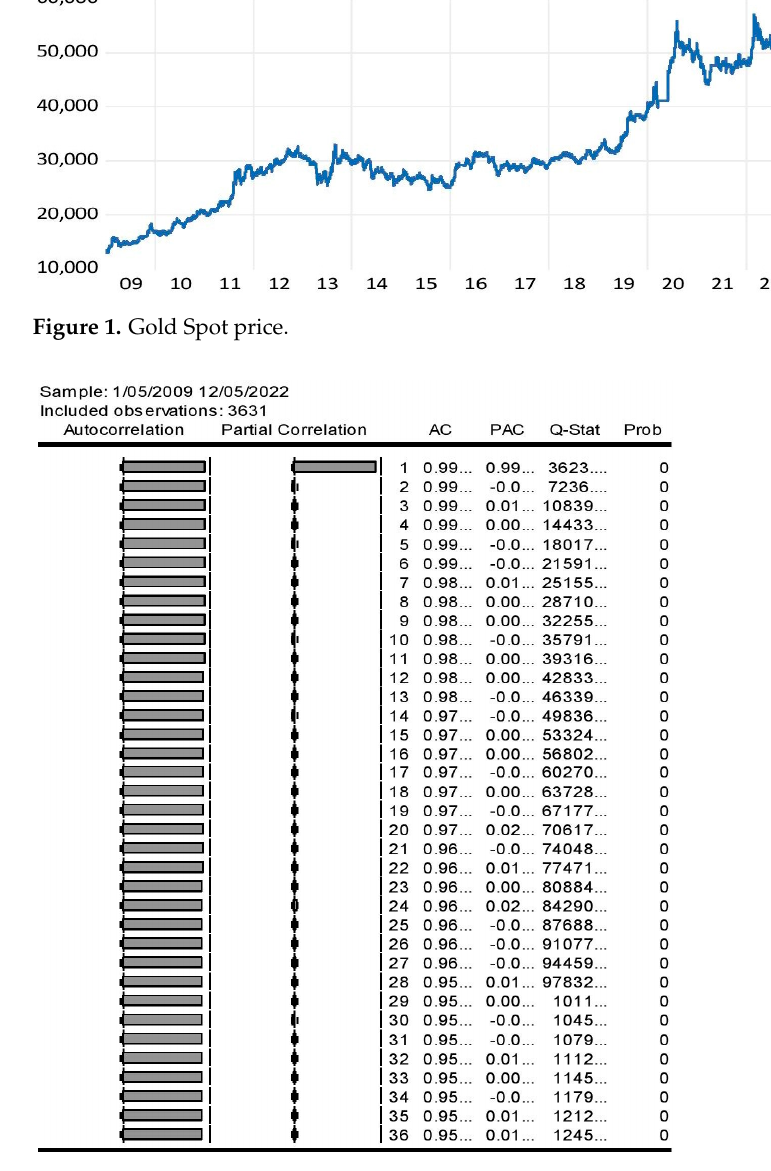
Figure 1. Gold Spot price.